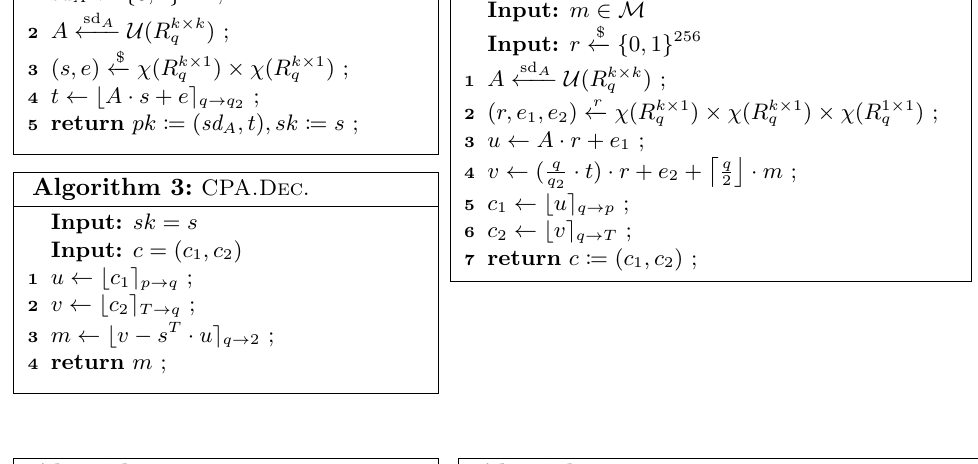
Algorithm 6: CCAKEM.Decaps